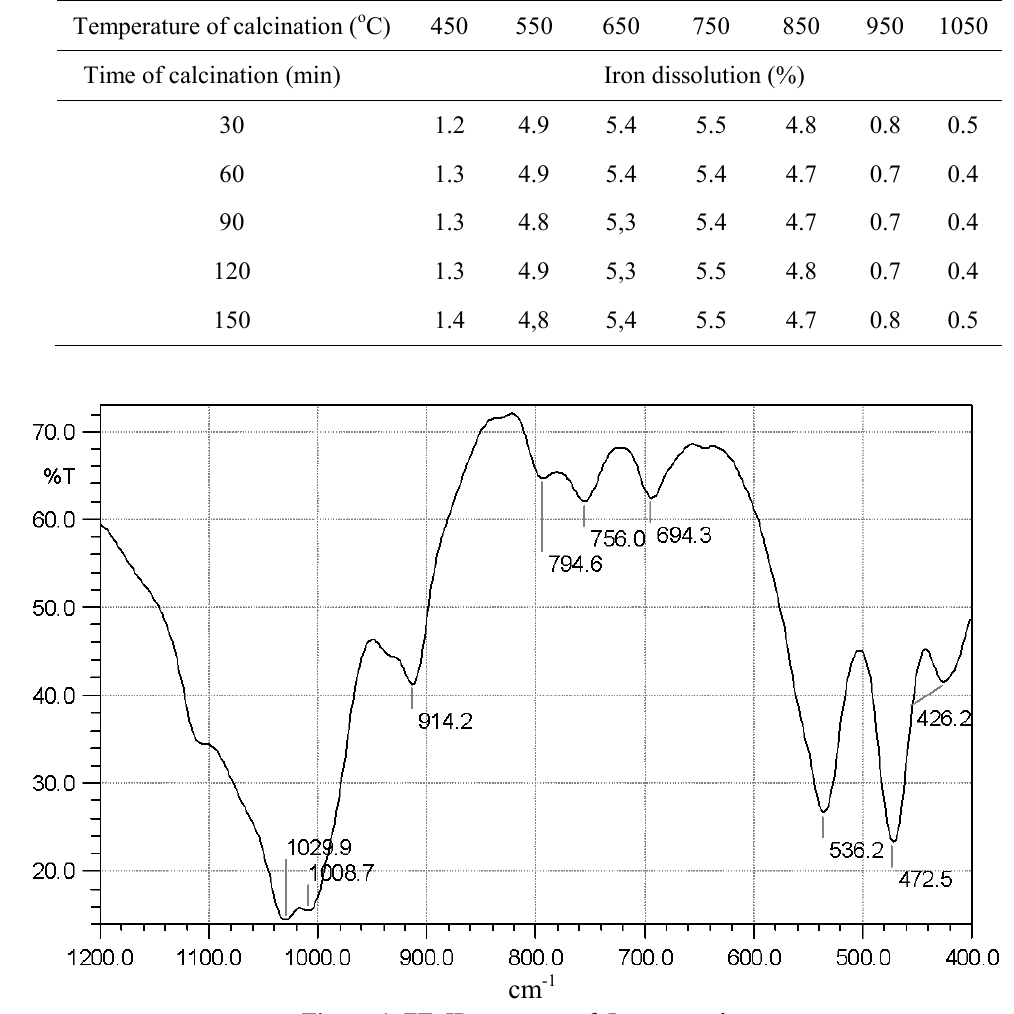
Table 2. Effect of calcination temperature and duration of on iron dissolution. Acid to clay ratio: 40 wt%; concentration: 2M sulfuric acid; extraction temperature: 80 o C; extraction duration: 30 min.